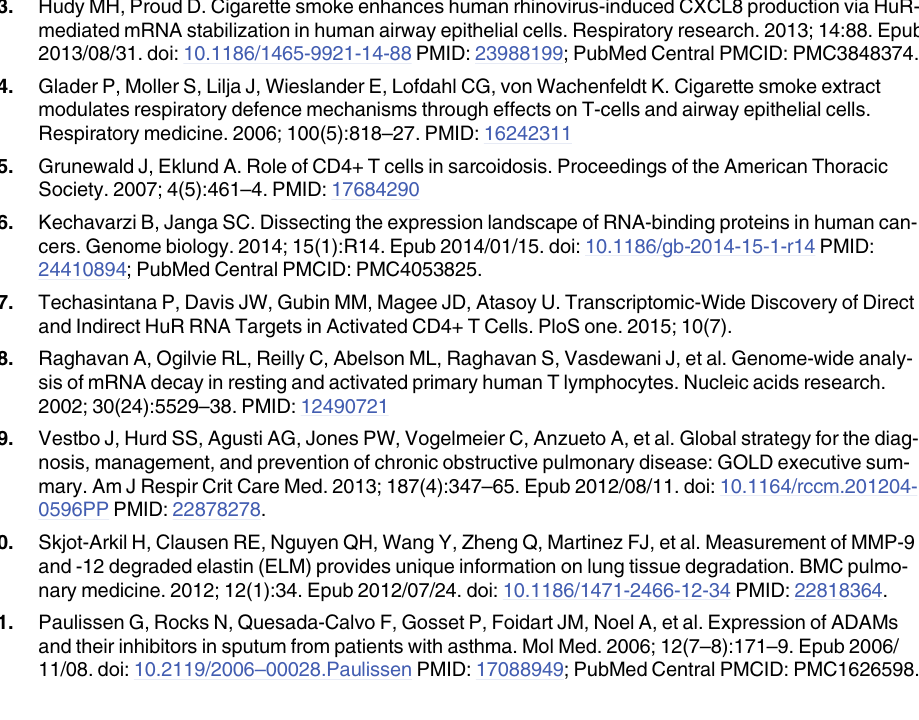
PLOS ONE | DOI:10.1371/journal.pone.0161669 August 30,